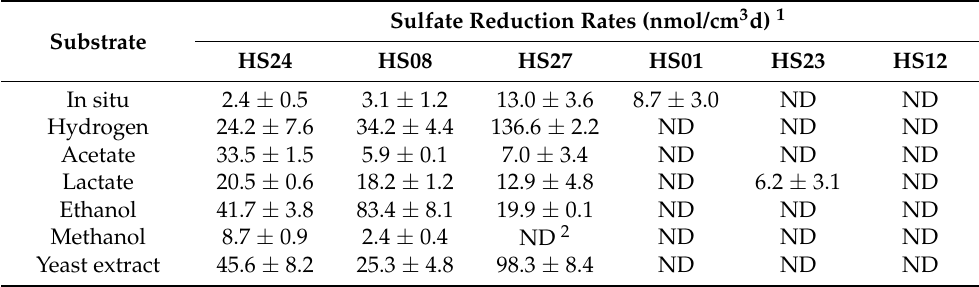
Table 2. Sulfate reduction rates observed in microcosm experiments amended different